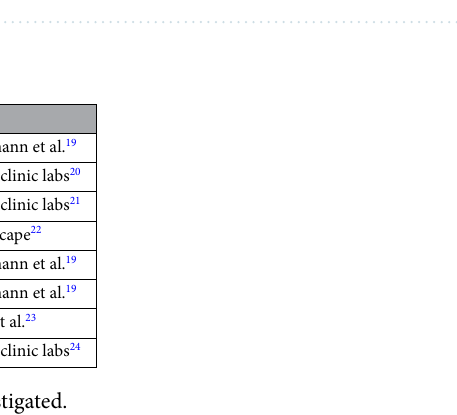
Table 1. Method comparison of existing literature.